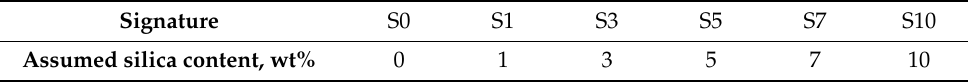
Table 1. Signatures of individual mixtures of polypropylene with silica waste .